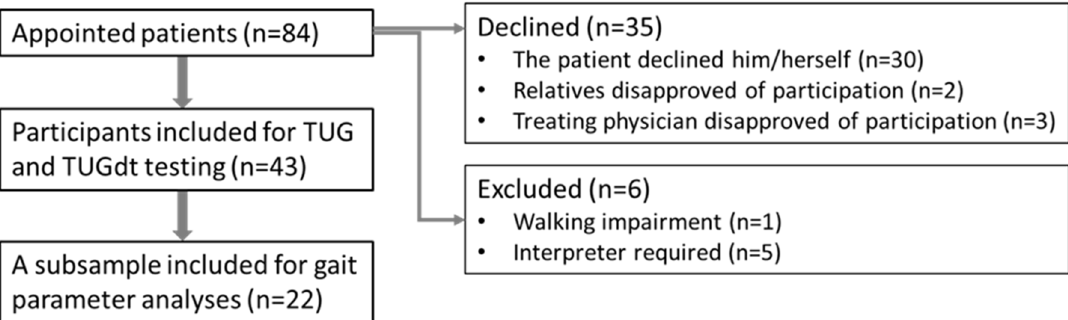
Figure 1. Flow chart for the inclusion in the pilot study.